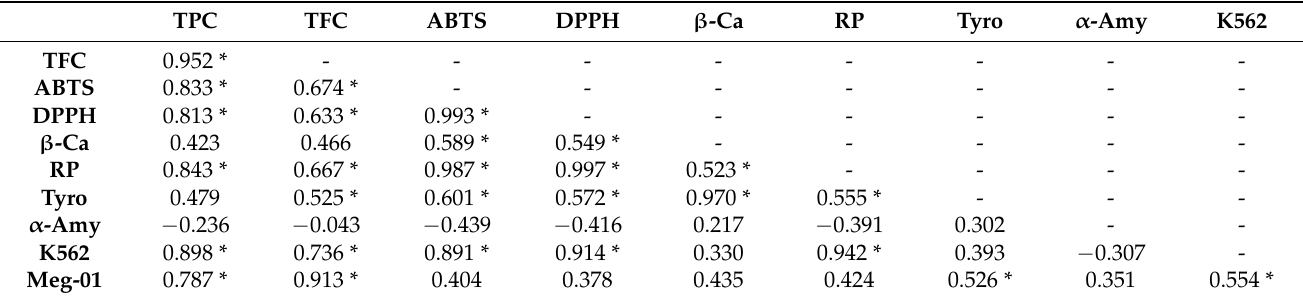
Table 4. Pearson’s correlation coefficients between total phenolic and flavonoid contents and biological activities of A. virginicus extracts.